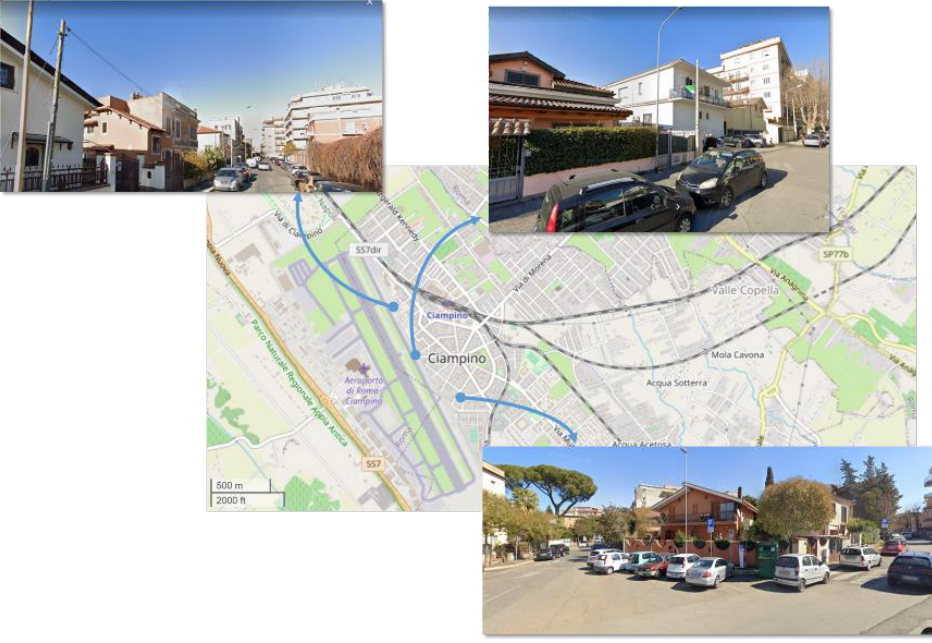
Figure 2. Proximity of the runway to the built environment and its quality.